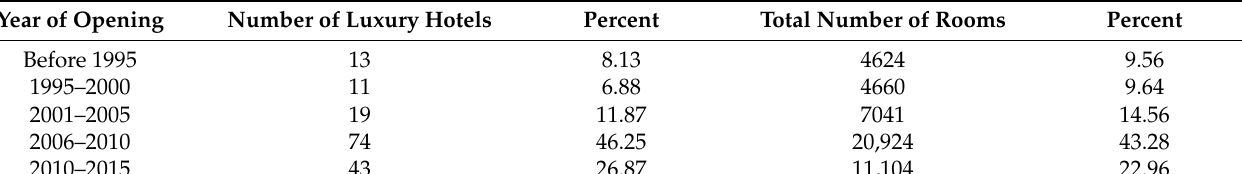
Table 2. Descriptive statistics of luxury hotels characteristics in Shanghai City.